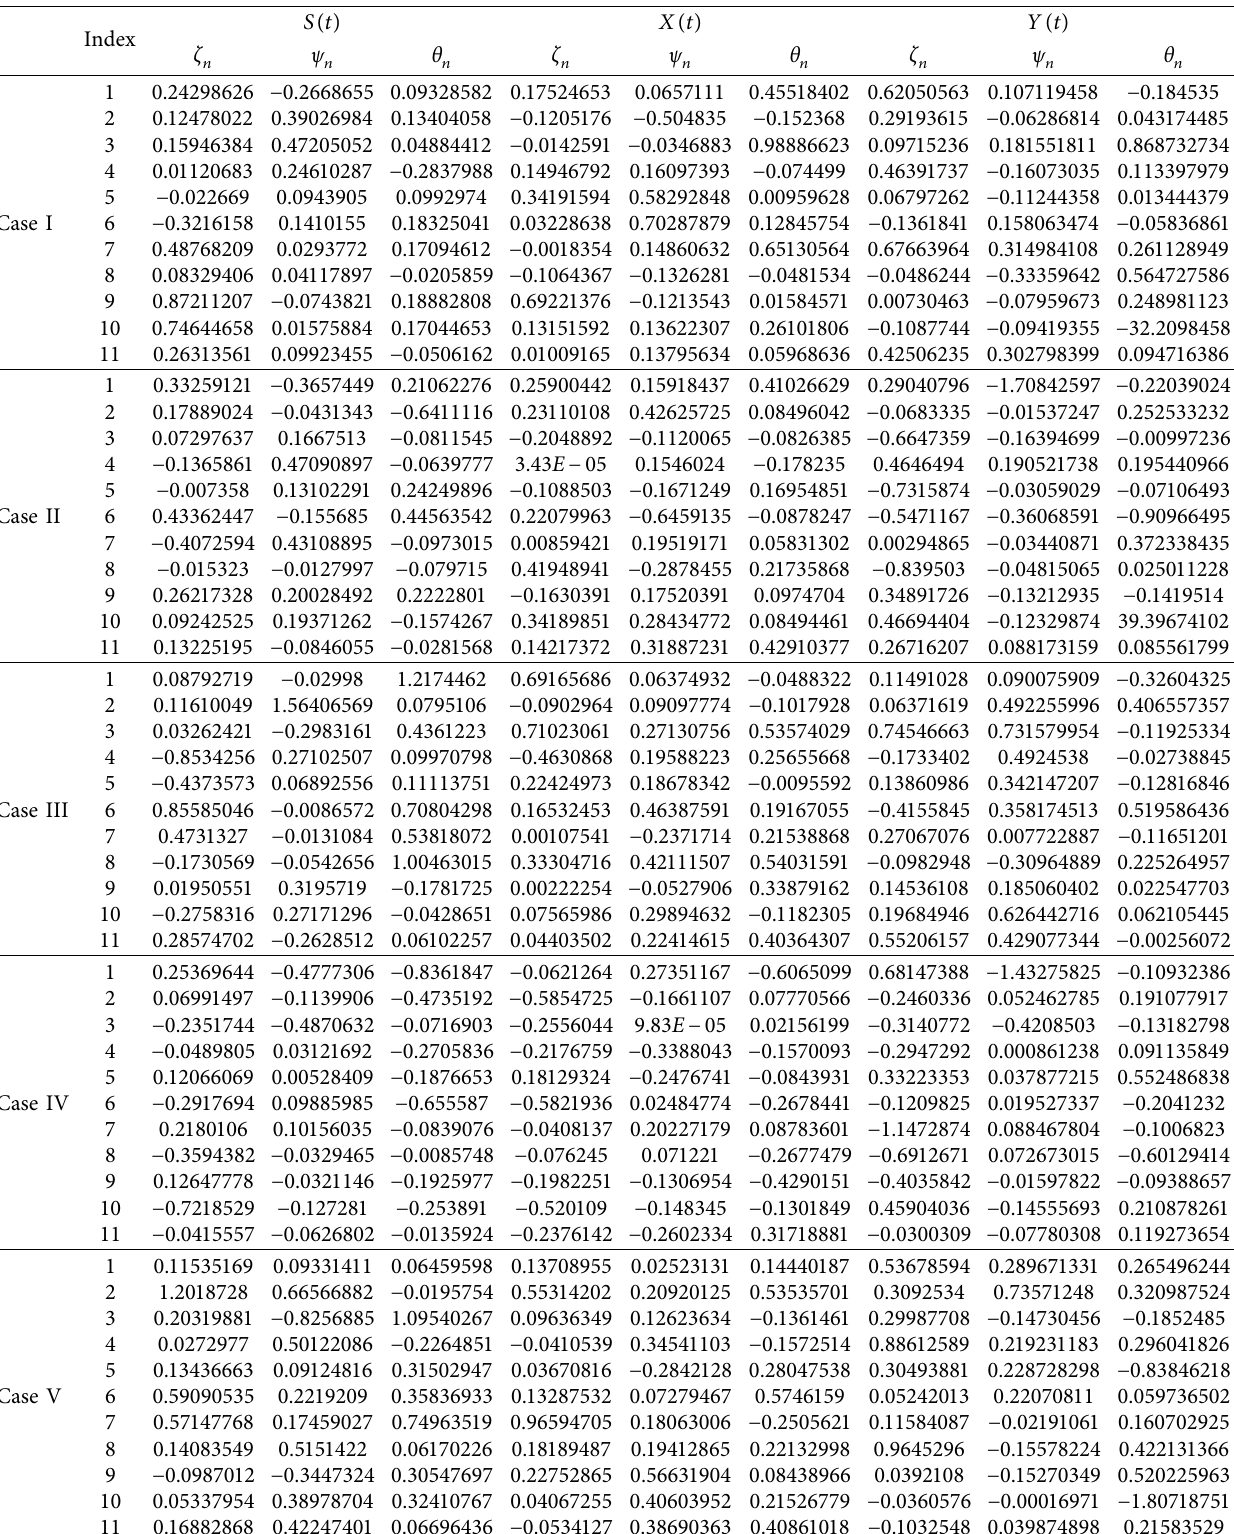
Table 11: Unknown parameters obtained by the LeNN-WOA-NM algorithm for the prey-predator model under the influence of variations in the intrinsic growth rate of local prey α 1